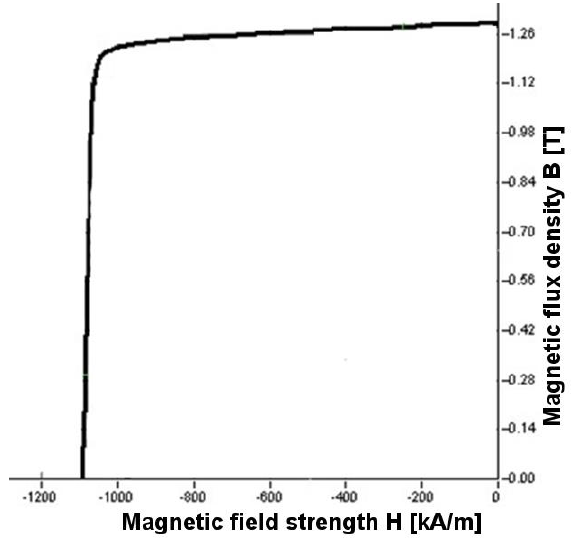
Figure 3. Magnetization characteristics of permanent magnet N42 [22]. A vector model (Figure 4), which was examined using finite element method analysis, was created for the magnetic circuit used in the experiment consisting of an AISI 60-40-18 cast iron element, permanent magnets, and an adjustable machining gap. The finishing zone was separated from the magnets by duralumin separators [23].